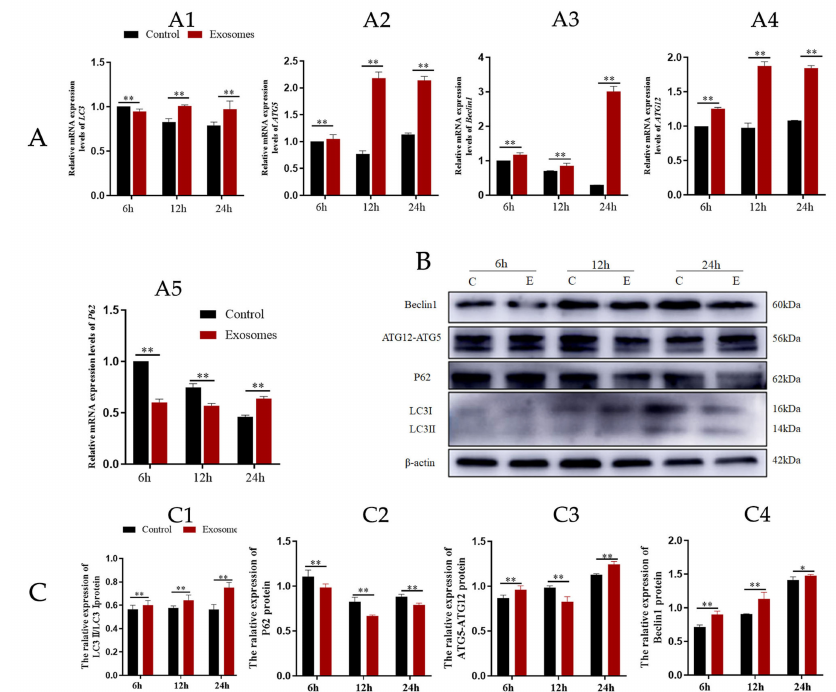
Figure 3. Yak follicular fluid can activate autophagy in YCCs. ( A ) Expression of autophagy-related genes LC3 ( A1 ), ATG5 ( A2 ), Beclin1 ( A3 ), ATG12 ( A4 ) and P62 ( A5 ) in YCCs using a qPCR assay. ( B ) Western blot analysis of protein expression in YCCs (C: control, E: Yak follicular fluid exosomes) (See Figure S2). ( C ) Quantitative results of Western blot analysis for LC3II/LC3I ( C1 ), P62 ( C2 ), ATG5- ATG12( C3 ) and Beclin1 ( C4 ). Data are expressed as the mean ± SD. n = 6. NS means no significant difference. * p < 0.05 and ** p < 0.01 indicate significant differences between the yak follicular fluid exosome treatments and the